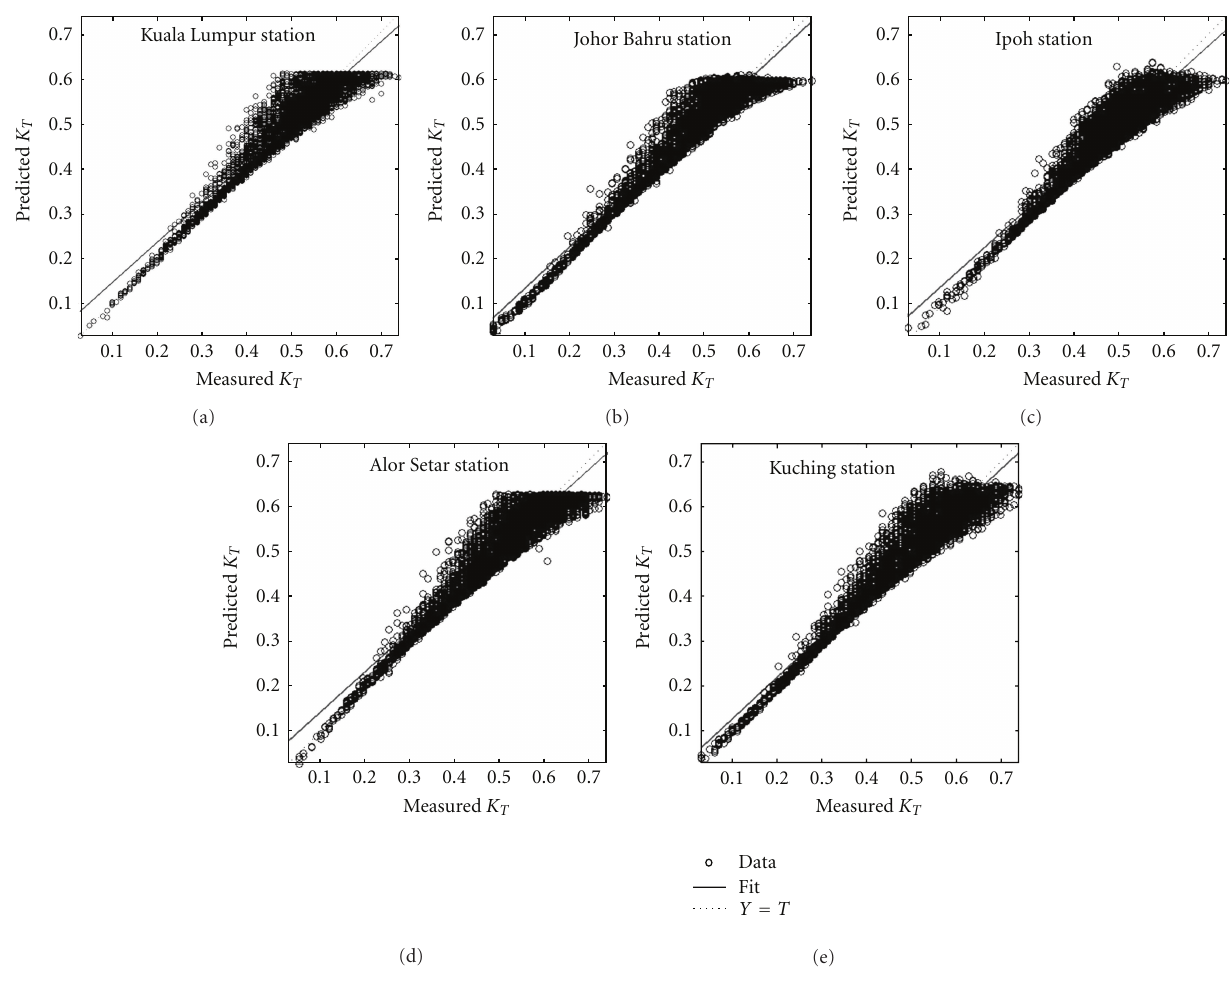
Figure 5: Comparison between measured and predicted clearness indexes.